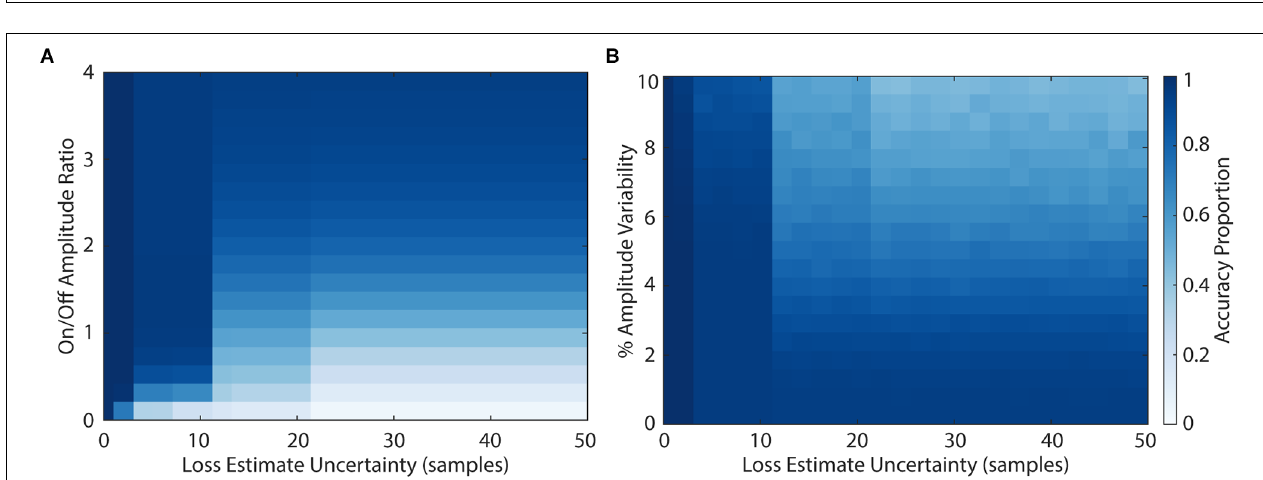
FIGURE 4 | Features of simulation. (A) Stimulation model fit to EEG data. Raw data are shown in gray and the model is shown in blue. (B) Histogram of missing data gap lengths for all experiments. (C) Histogram of continuous run lengths for all experiments. (D) Histogram of longest continuous runs in each experiment.